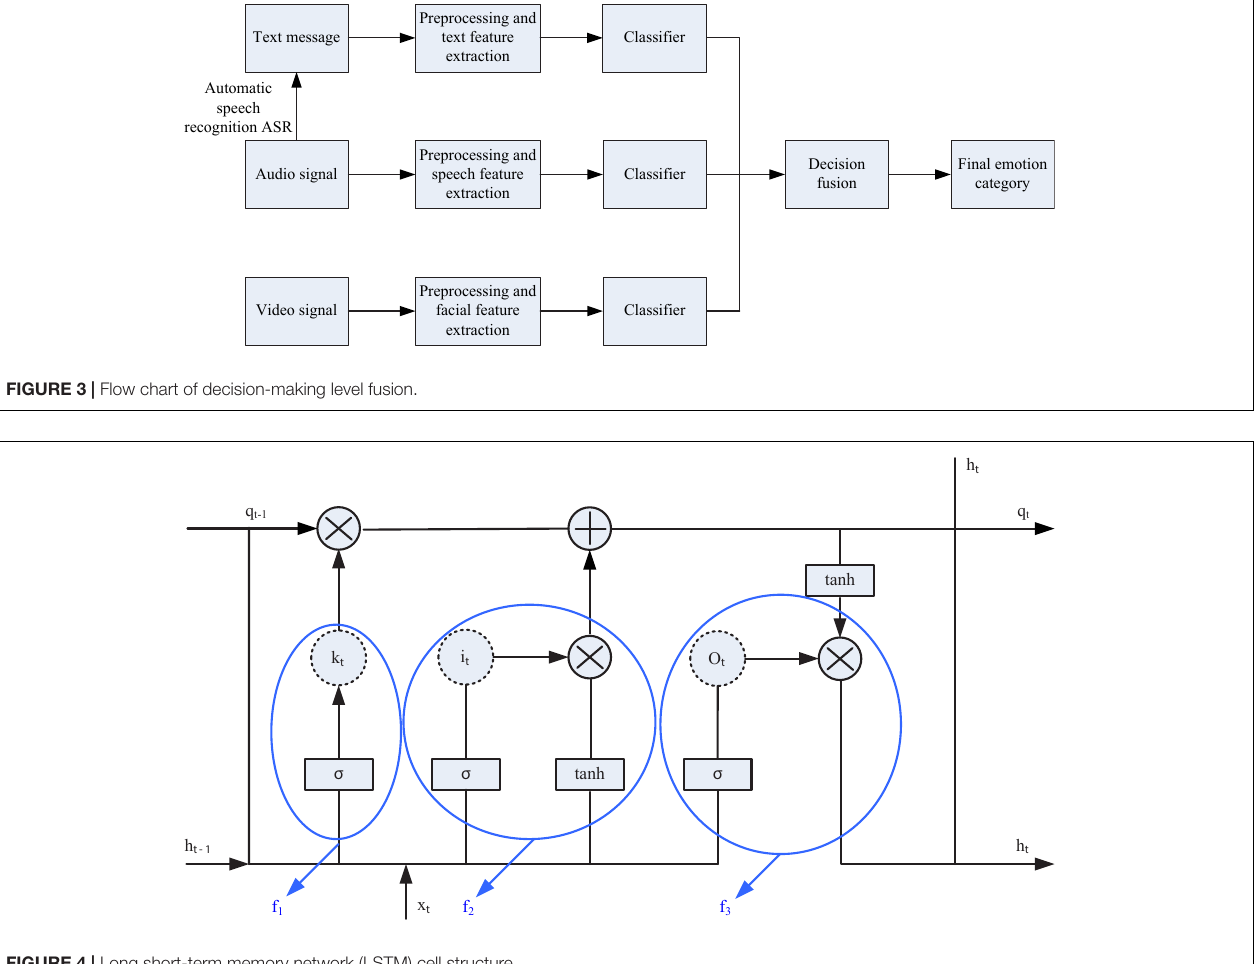
FIGURE 4 | Long short-term memory network (LSTM) cell